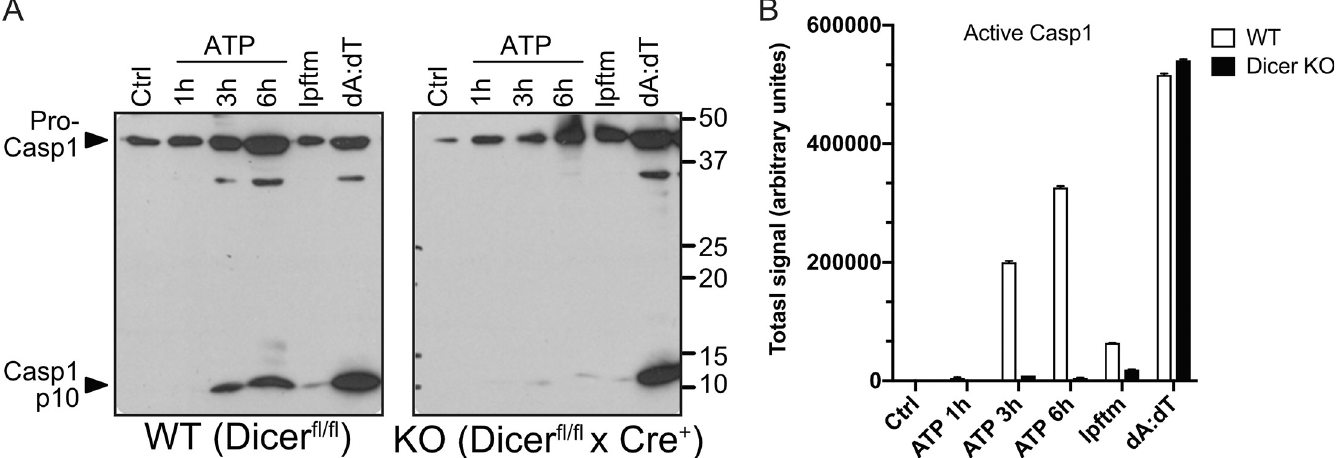
Fig 2. Dicer is required for activation of caspase-1 following stimulation of the NLRP3 but not the AIM2 inflammasome. ( A ) Day 7 bone marrow macrophages prepared from Dicer fl/fl x ER T -Cre - (WT) or Dicer fl/fl x ER T -Cre + (KO) mice were primed with 1 μ g/ml LPS for 4 h (signal 1) before stimulation with 5 mM ATP for 1, 3 or 6 hours or transfected (lipofectamine; lpftm) with 1 μ g/ml poly dA:dT (dA:dT) for 6 hours (signal 2). Secreted caspase-1 (casp1) levels were then evaluated by immunoblotting. Arrows indicate the inactive caspase-1 zymogen (pro-casp1) and the active form (casp1 p10). ( B ) Quantitative analysis of the mature secreted form of IL-1 β shown in panel A.